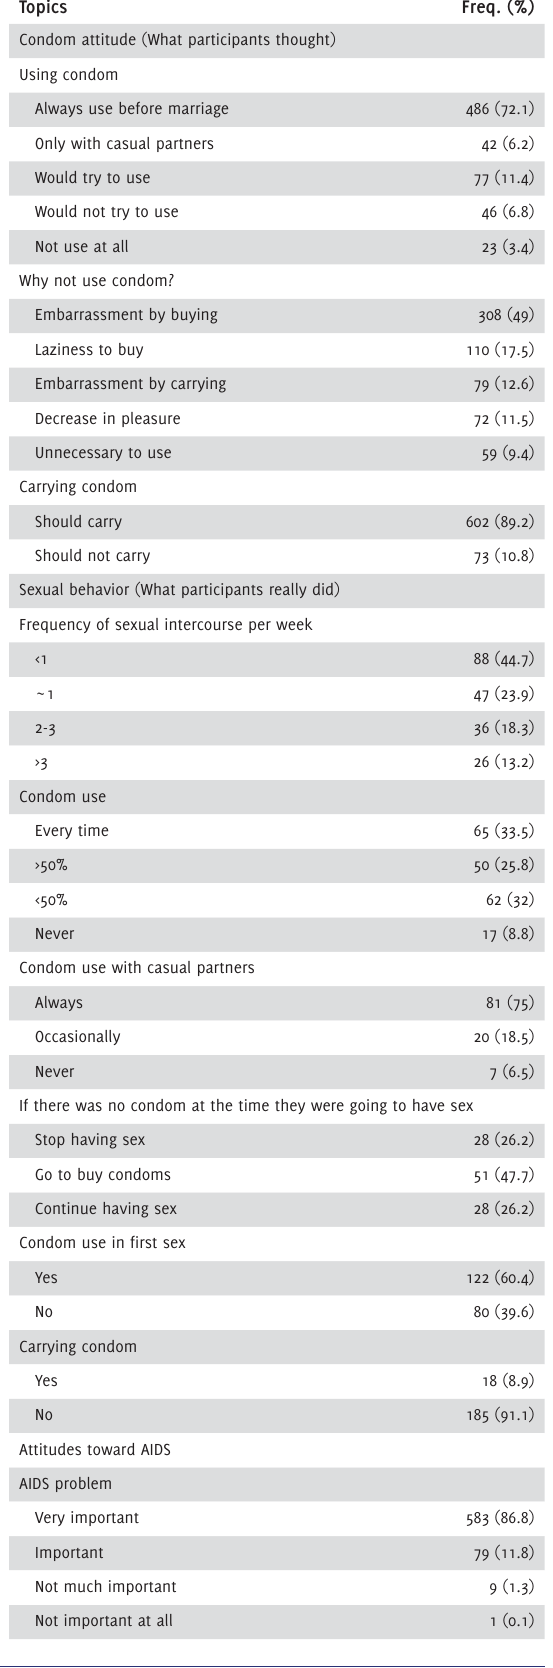
Table 2. Summary of results.